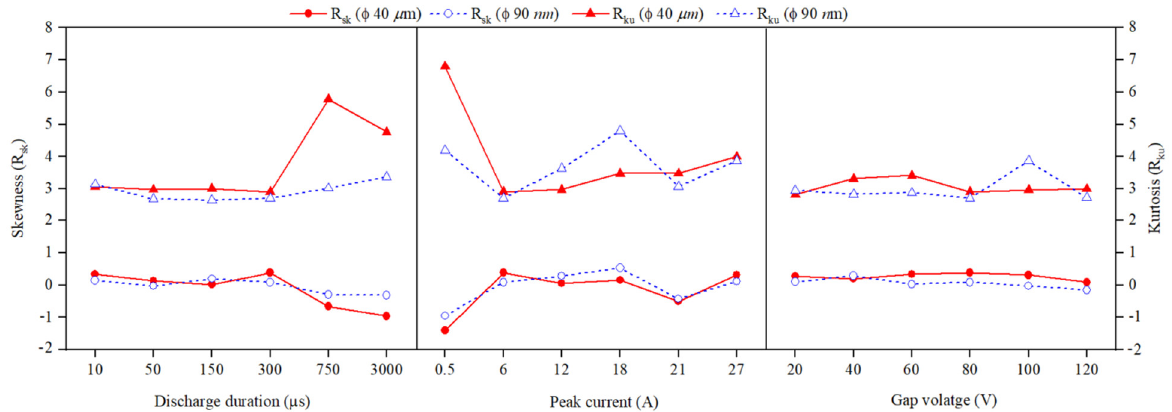
Figure 18. Effect of input process parameters on Skewness and Kurtosis.